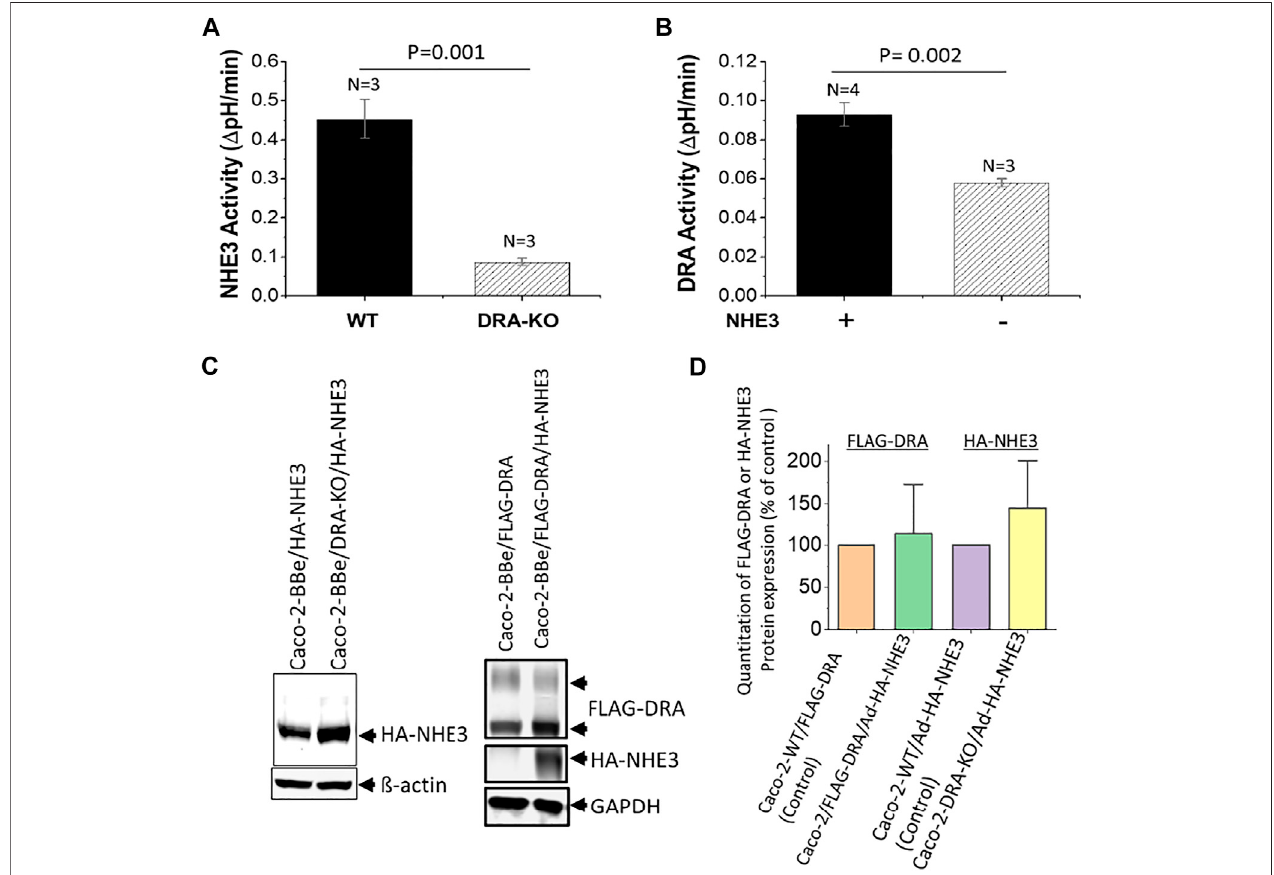
FIGURE3| ReciprocaldependenceofbasalNHE3andDRAactivitiesinCaco-2-BBecells. (A) .NHE3activityismeasuredasachangeinpH i causedbyapicalNa + addition to acutely NH 4 Cl − acidi fi ed cells expressing BCECF. Comparison is between cells in which DRA is KO by CRISPR/Cas9. n is the number of separate experiments. (B) . DRA activity ismeasured as apical Cl − removal in presence ofHCO 3 − -dependent alkalinization determined withBCECF. Comparison is between wild- typecellsandthoseinwhichNHE3isexogenouslyexpressedbyadenoviraltransduction.nisthenumberofseparateexperiments. (C) .WesternblotsofNHE3and DRA expression in the conditions shown in Figures 3A,B demonstrate that the cross-dependence of NHE3 and DRA was not dependent on their protein expression level. Single experiments are shown. (D) . Quantitation of Western blots from three experiments as in Figure 3C . The results are expressed as mean ± SEM. n = 3, and results are not signi fi cantly different than the individual